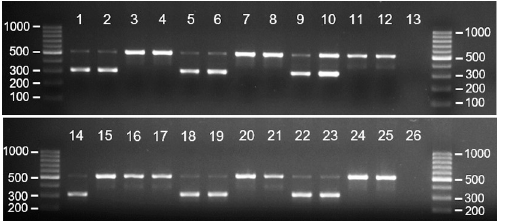
Fig 2. Gel electrophoresis of PCR products amplified using mCHD1F/mCHD1R primer pair and DNA extracted from blood. Lane numbers correspond to the samples listed in Table